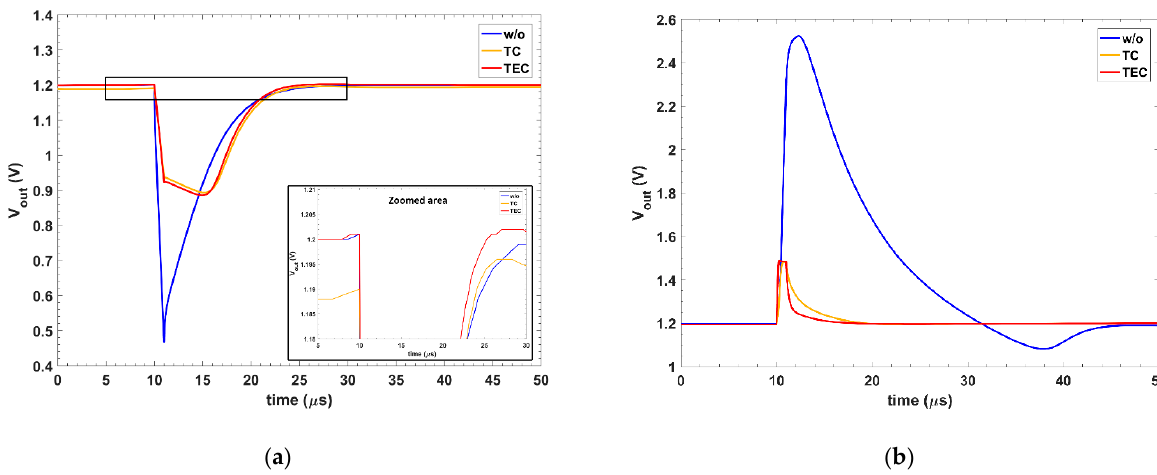
Figure 16. Line transient behavior: with and w/o the TC and TEC transient circuits for I Load 50 mA: ( a ) undershoot and ( b ) overshoot.